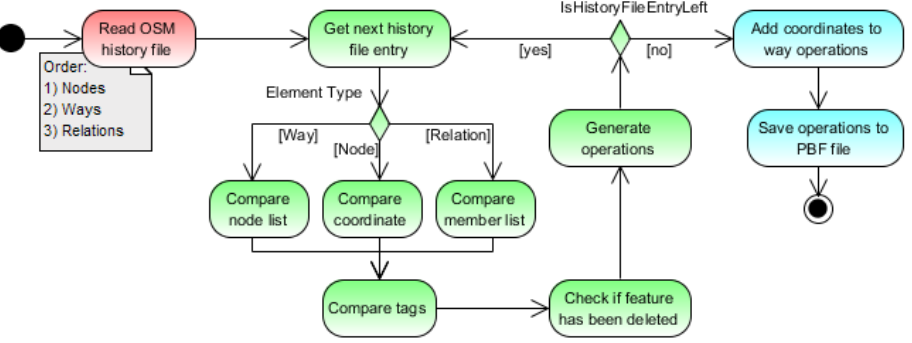
Figure 4. Workflow for extracting operations from the OSM Full History File [18].